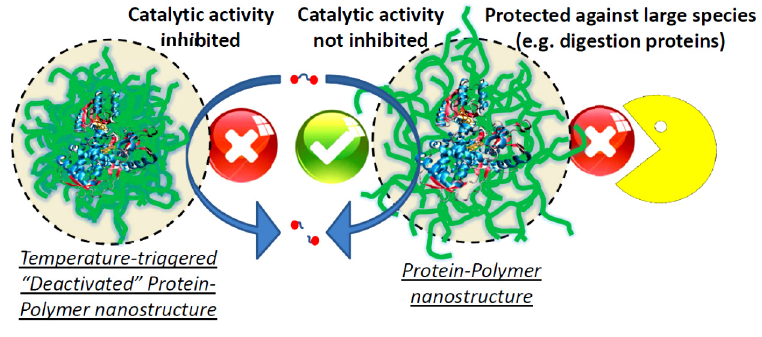
Figure 7. Schematic representation of a protein-polymer nanostructure, which is able to use the catalytic properties of the protein, but at the same time displays protection against denaturing media or larger digestive protein structures. Additionally, the catalytic activity can be inhibited by a collapse of the surrounding polymer layer, e.g., temperature in combination with